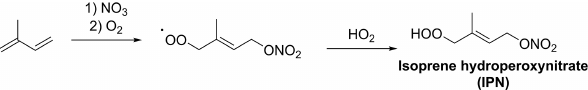
Figure 3. NO 3 -initiated formation of IPN. The formation of 1,4- IPN is shown here; other IPN isomers, as well as additional reaction products, will also be